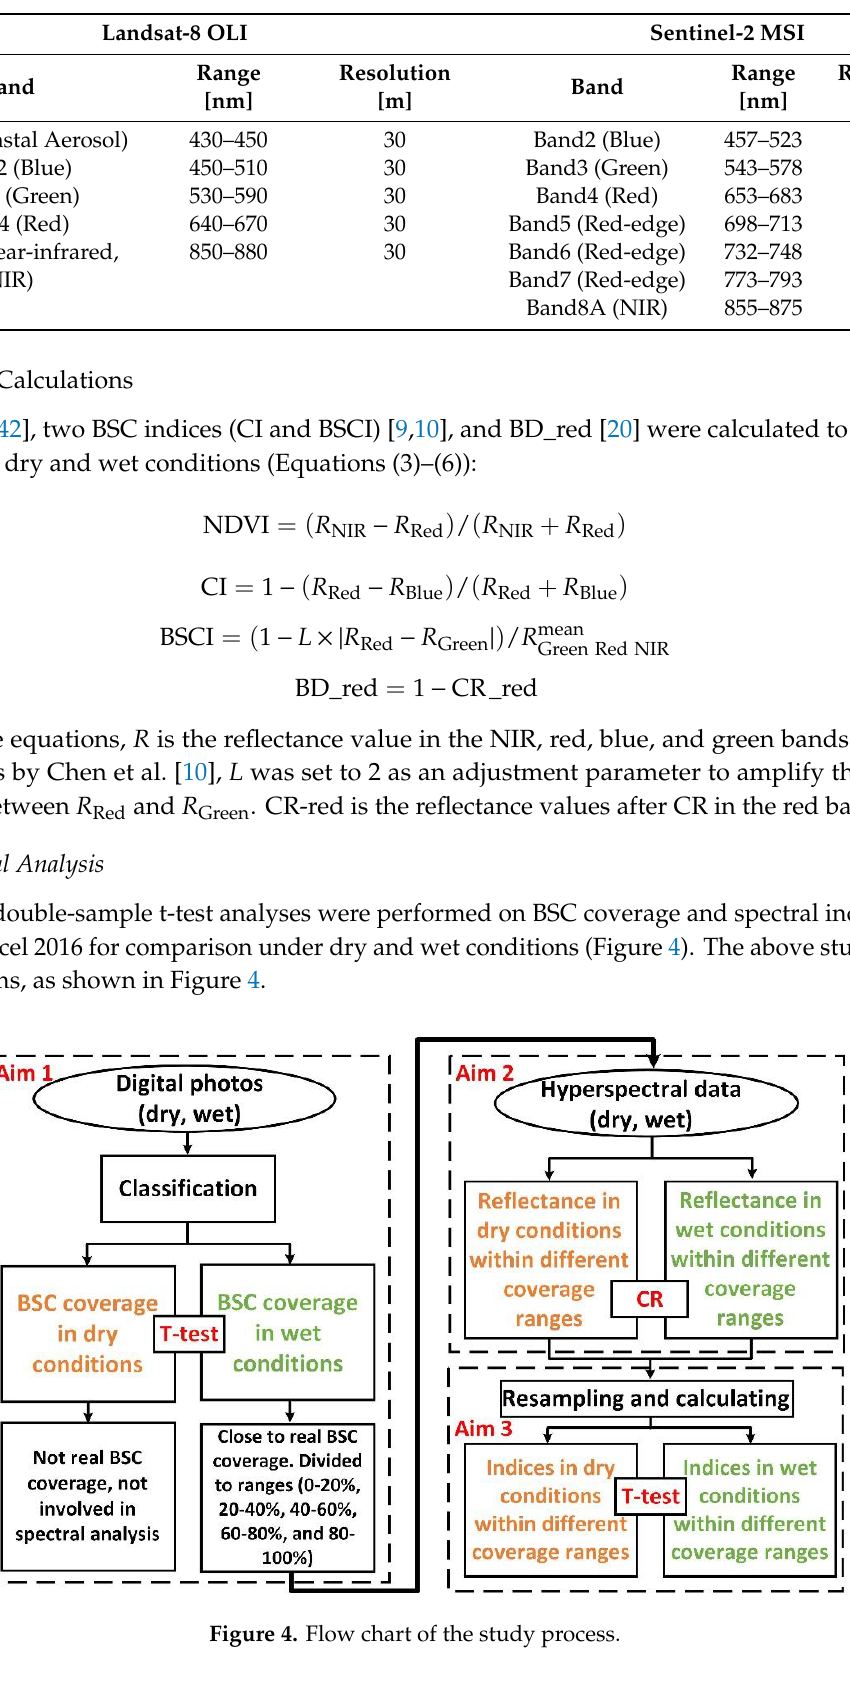
Table 2. Landsat-8 Operational Land Imager (OLI) and Sentinel-2 Multispectral Instrument (MSI) spectral bands used in this study [17].